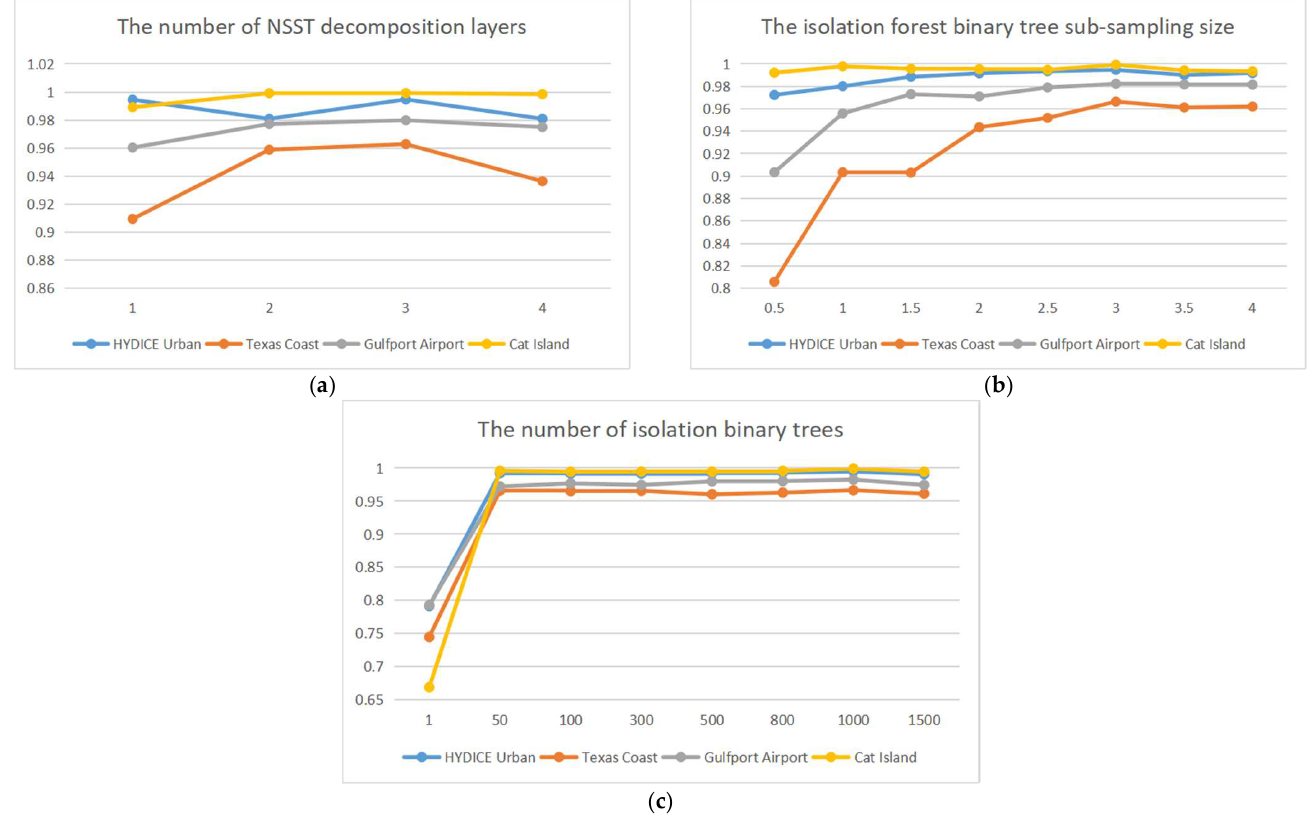
Figure 8. Influence of different parameters on SI2FM algorithm detection performance. ( a ) The number of NSST decomposition layers; ( b ) The isolation forest binary tree sub-sampling size; ( c ) The number of isolation binary